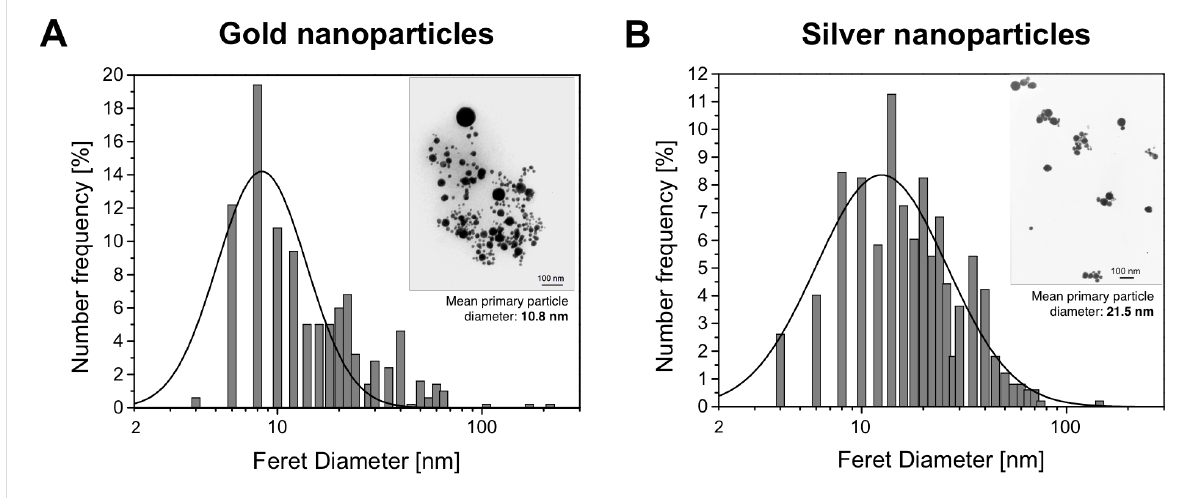
Figure 1: Number distribution of nanoparticle size including corresponding TEM micrographs as inserts of (A) gold nanoparticles and (B) silver nanoparticles.